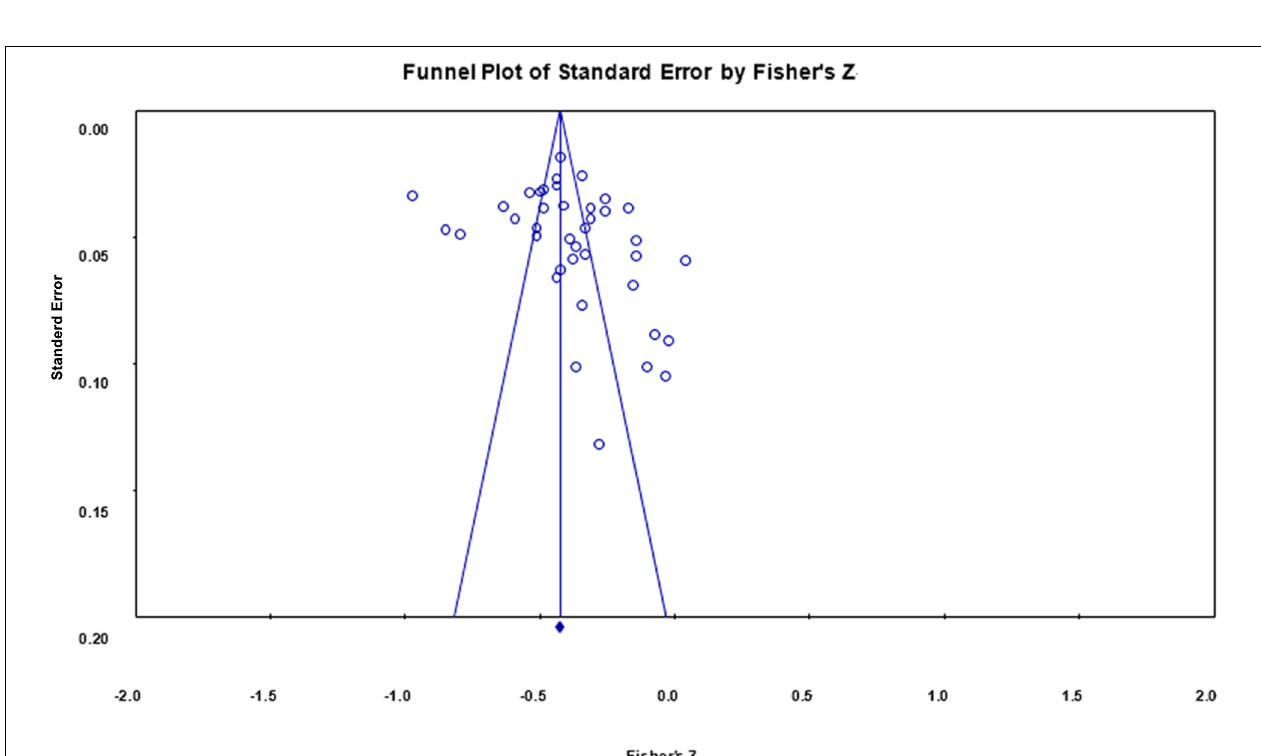
FIGURE 5 | Funnel plot of effect sizes of the correlation between restraint indicator and Internet addiction.